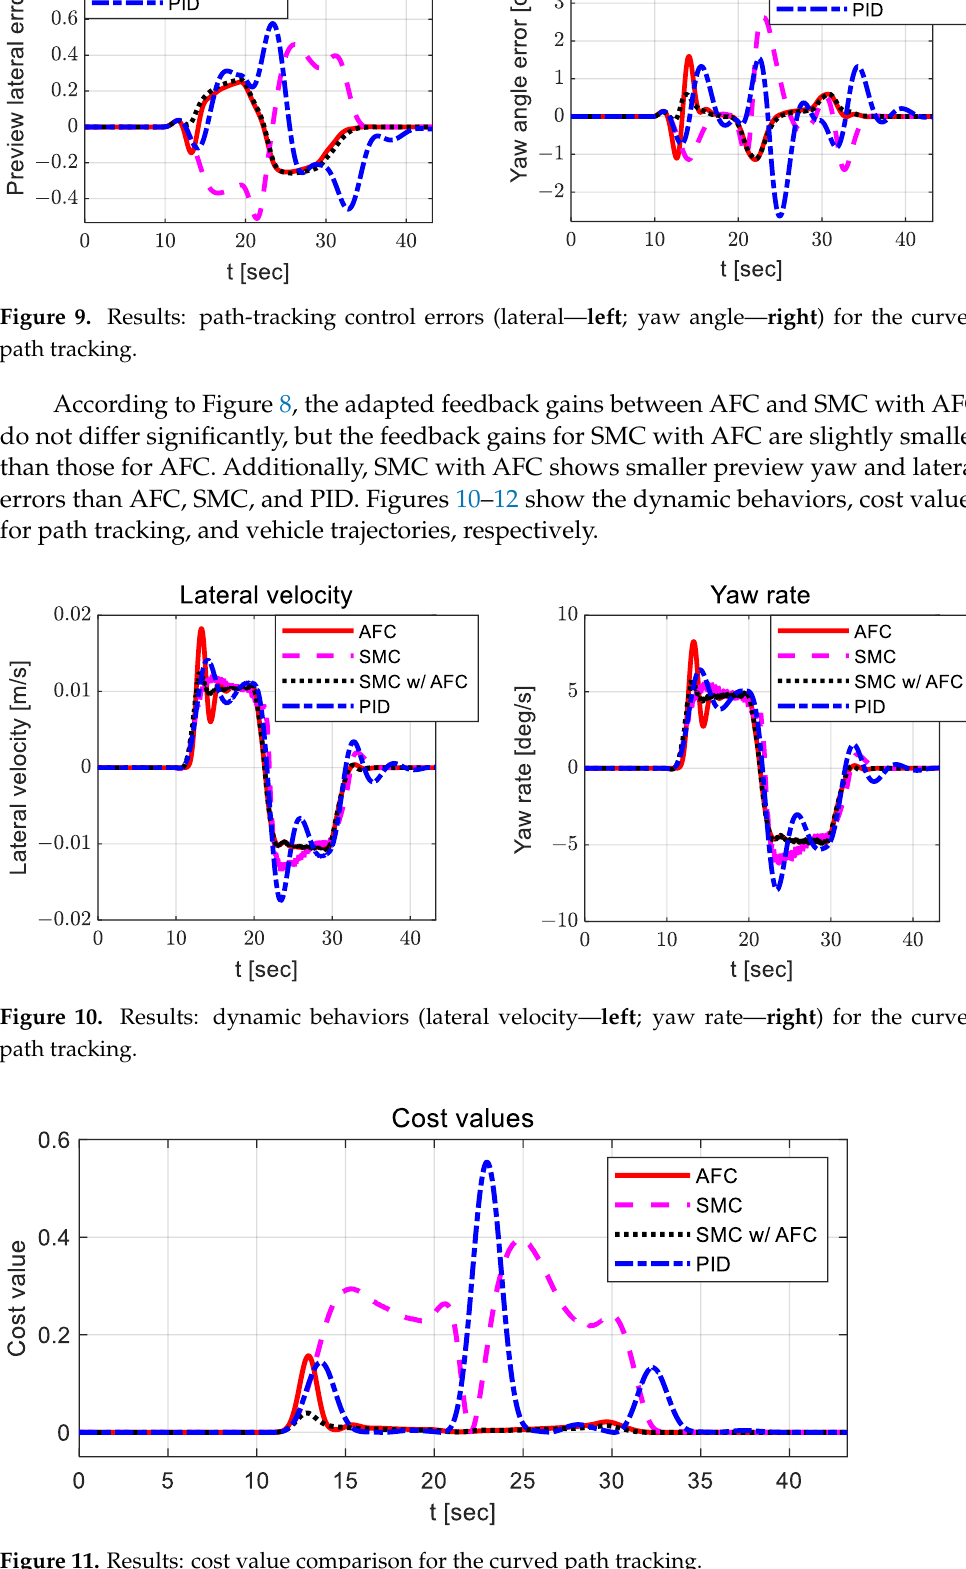
Figure 11. Results: cost value comparison for the curved path tracking.